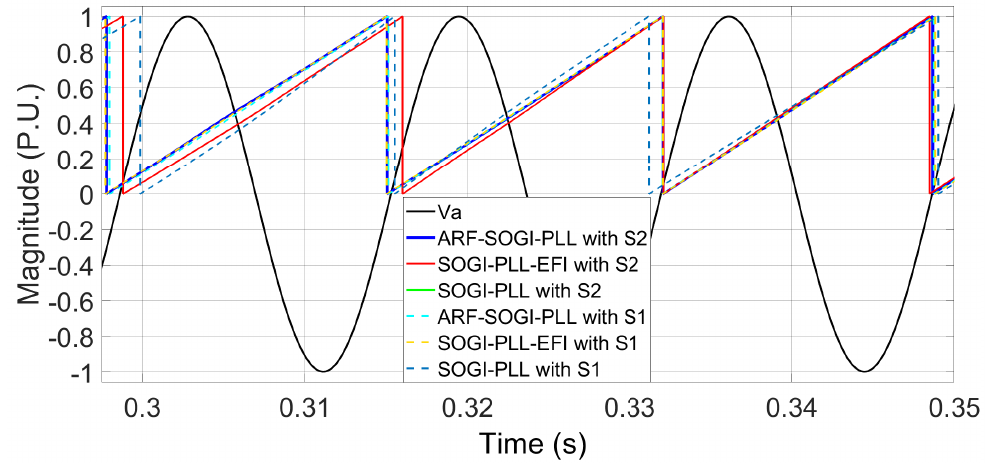
Figure 16. ω t during the synchronization process, from the third to the sixth cycle after system recovery following a phase-to-ground short-circuit.